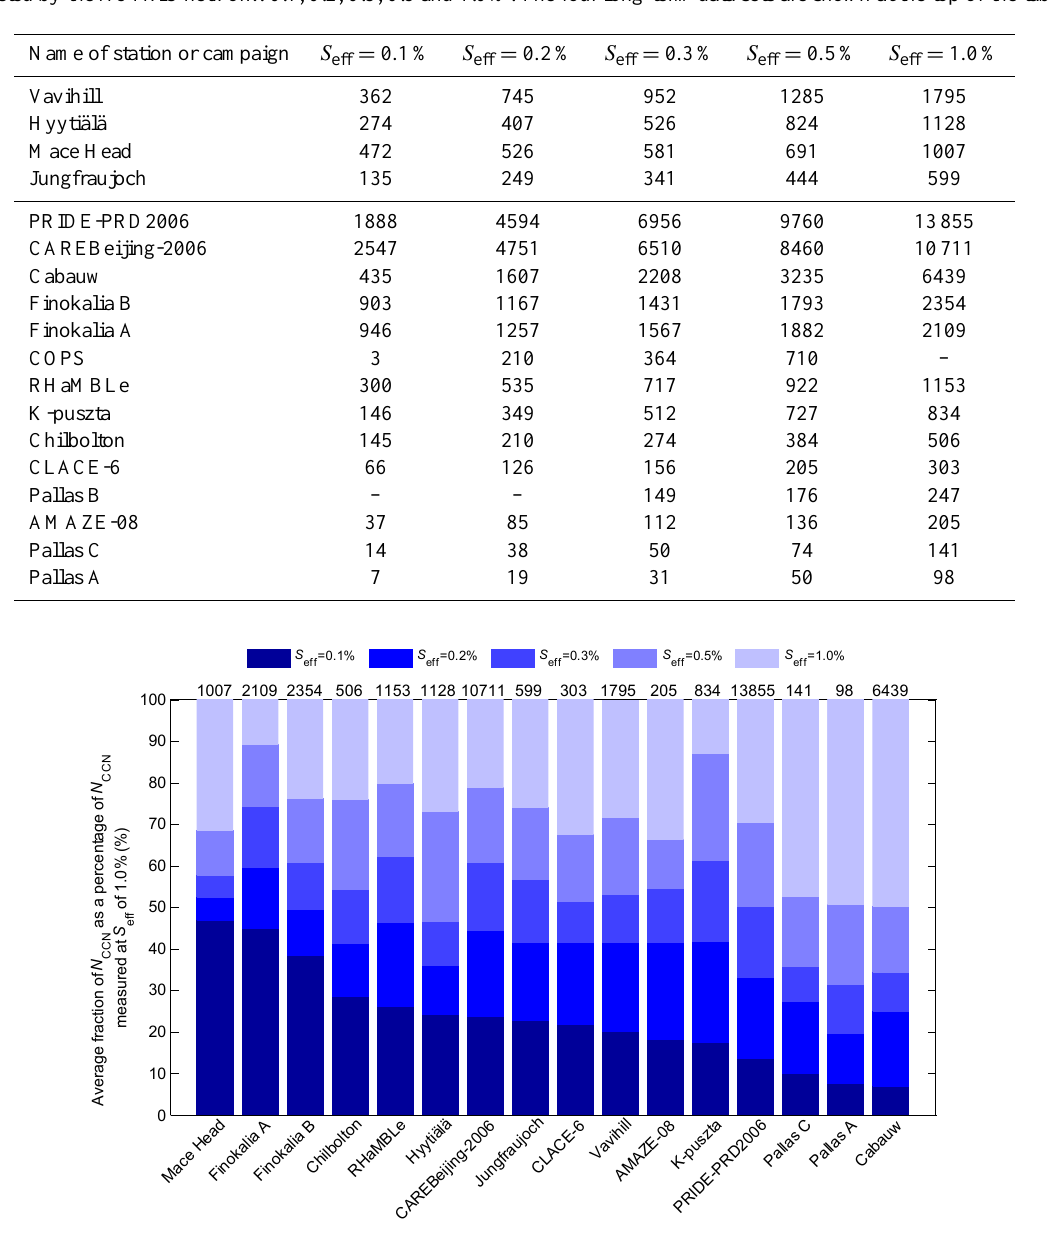
Figure 3. Average cumulative N CCN for all available locations shown as a percentage of the N CCN measured at the S eff of 1.0% (above each bar). Colours indicate the supersaturation S eff